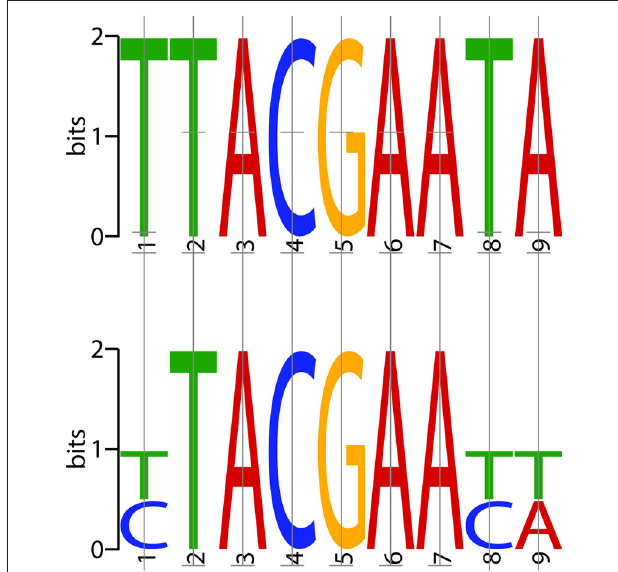
FIGURE 2 | Consensus CIN-box of S. pneumoniae and S. suis . The consensus CIN-box identified in S. pneumoniae (top) is compared to that identified for S. suis (bottom) using MEME with the FIMO plug in (http://meme- suite.org/doc/overview.html). The MEME motifs represent the probability of each possible DNA nucleotide appearing at each possible position in an occurrence of the motif. The possible letters are A , C , G , and T , adenine, cytosine, guanine, or thymine, covalently linked to a phosphodiester backbone. The height of the individual letters in a stack represents the probability of the letter at that